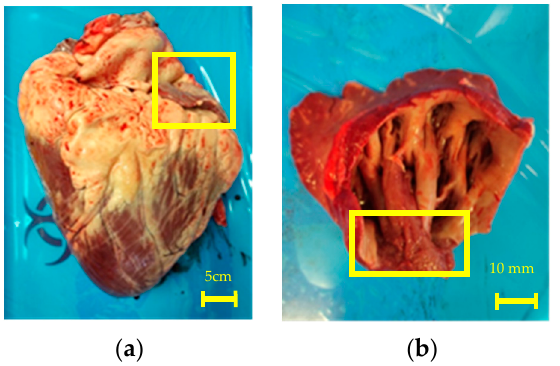
Figure 3. ( a ) Left picture shows the first sample bovine heart with the LAA highlighted; ( b ) The right picture shows the dissected LAA from sample one. The yellow square shows the position of the LAA pectinate muscle where the measurements were taken.